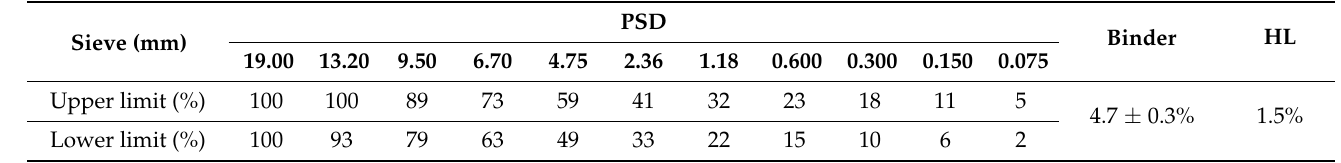
Table 5. 14 mm DG mix parameters conforming to MRWA Specification 504 [20].